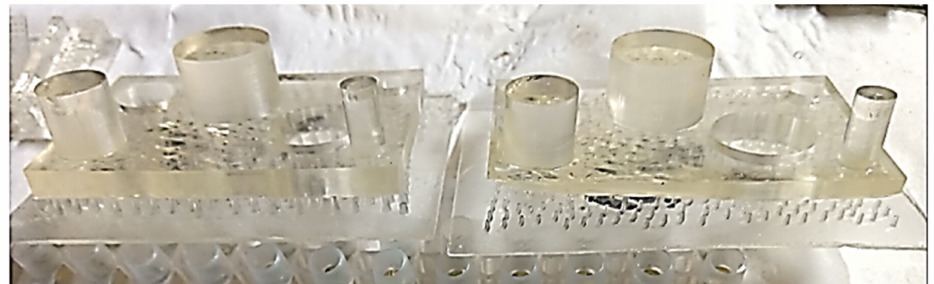
Figure 6. The clear parts printed with 8 s time: heavy structure on the left and medium structure on the right.